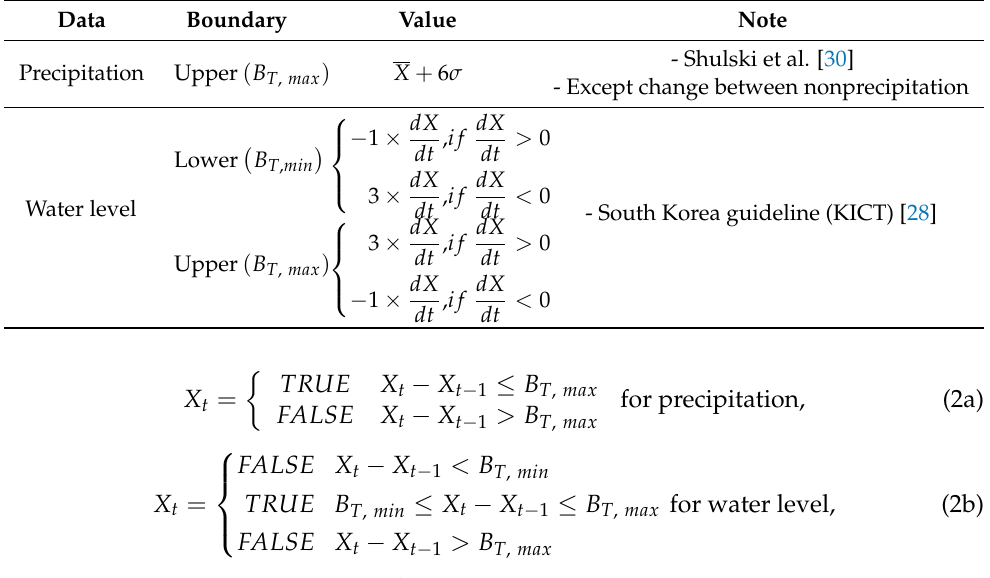
Table 3. Validation boundaries applied for trend check